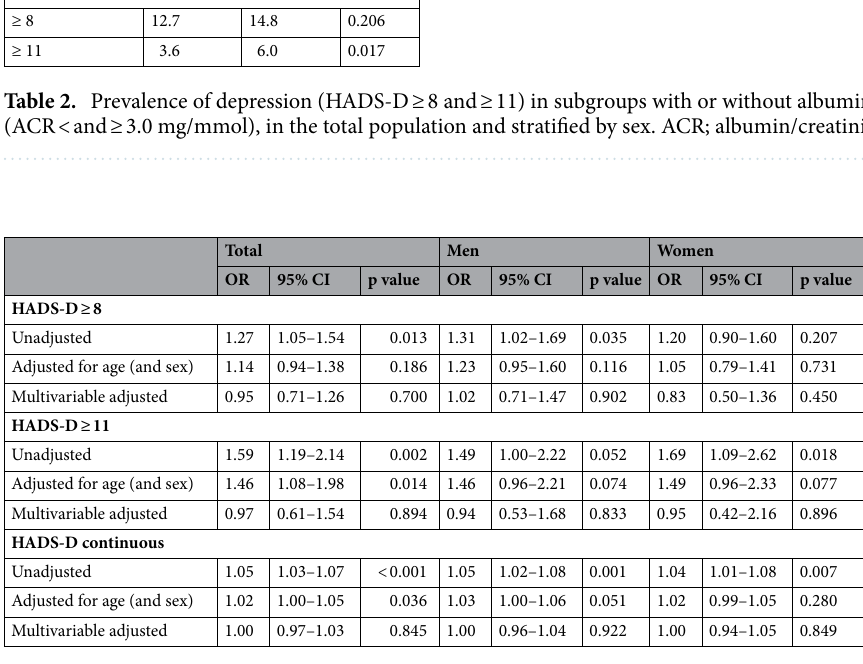
Table 3. Odds ratio (OR) for moderately increased albuminuria (ACR ≥ 3.0 mg/mmol) according to different HADS-D subgroups/scores. Mulitvariable adjusted for age, sex (in the total population), systolic